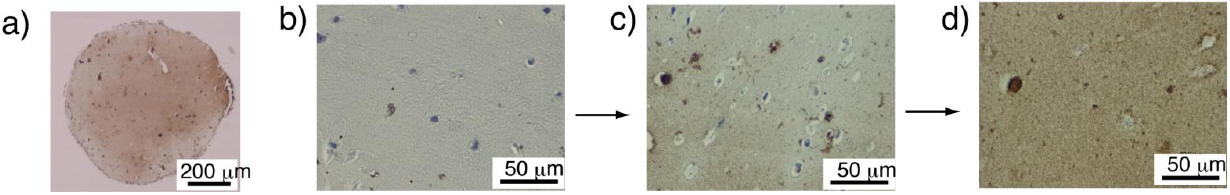
Figure 4. ( a ) Representative image of von Kossa-stained 3D construct (day 35); ( b–d ) Brown color indicating mineral deposition darkened over the cell culture period (b: day 28, c: day 35, d: day 42).